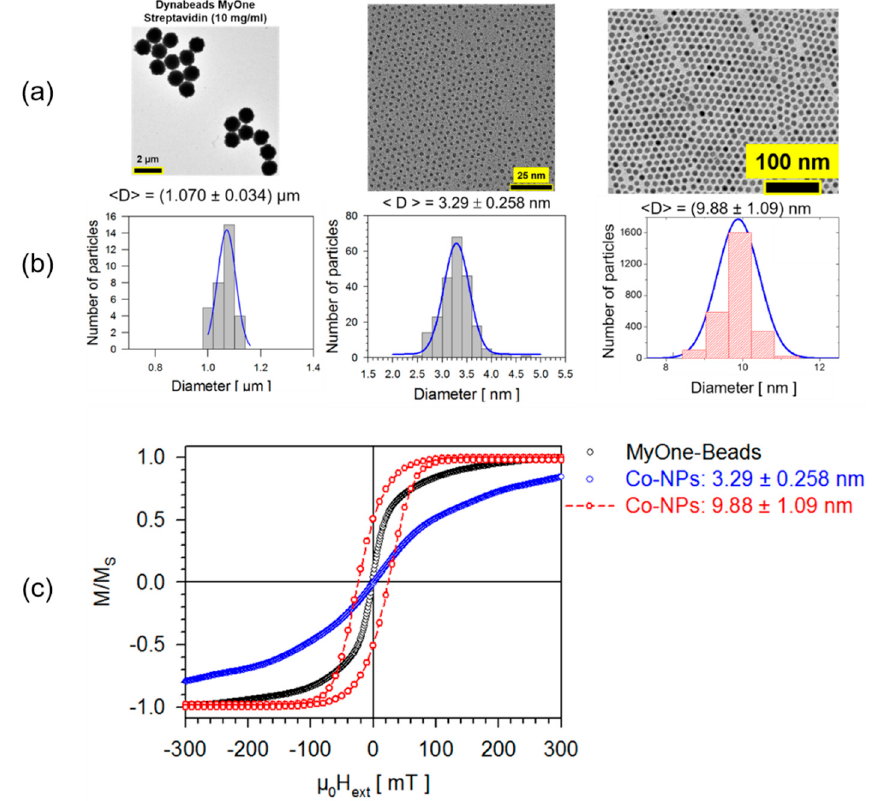
Figure 3. Comparison between hysteresis curves of MyOne beads and Cobalt nanoparticles synthesized via thermolysis [38]. ( a ) Microstructure of each species taken by transmission electron microscopy (TEM); ( b ) The corresponding particle size distribution derived from the TEM analyses; ( c ) Normalized magnetization reversals of each species.